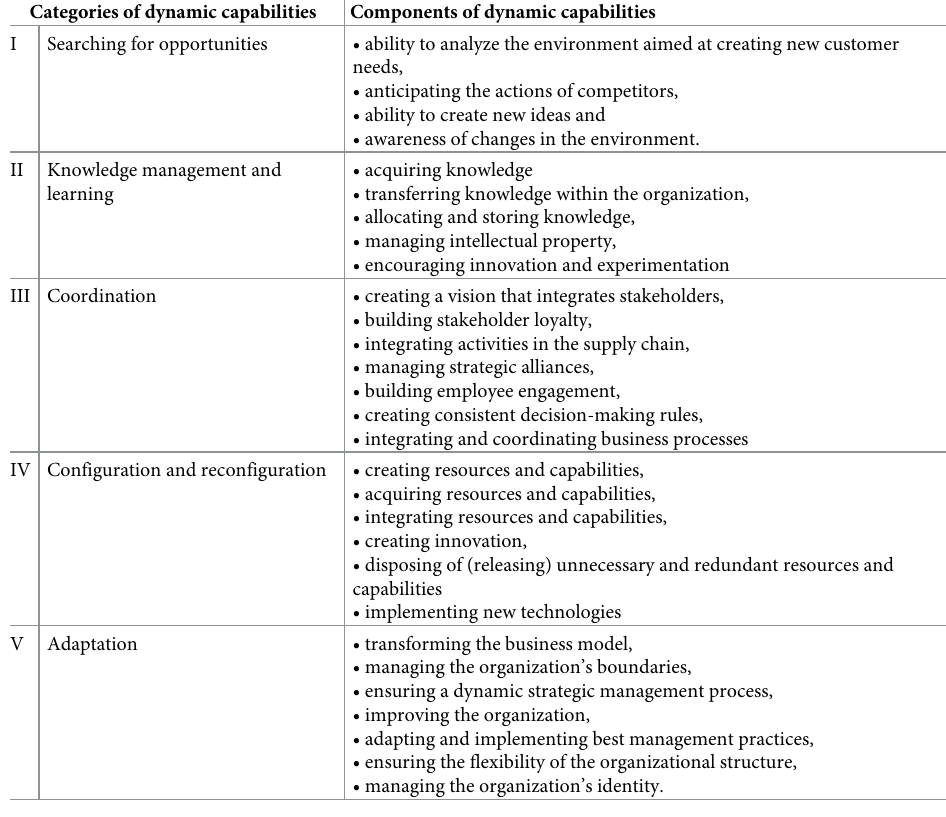
Table 1. Categories of dynamic capabilities studied in the research